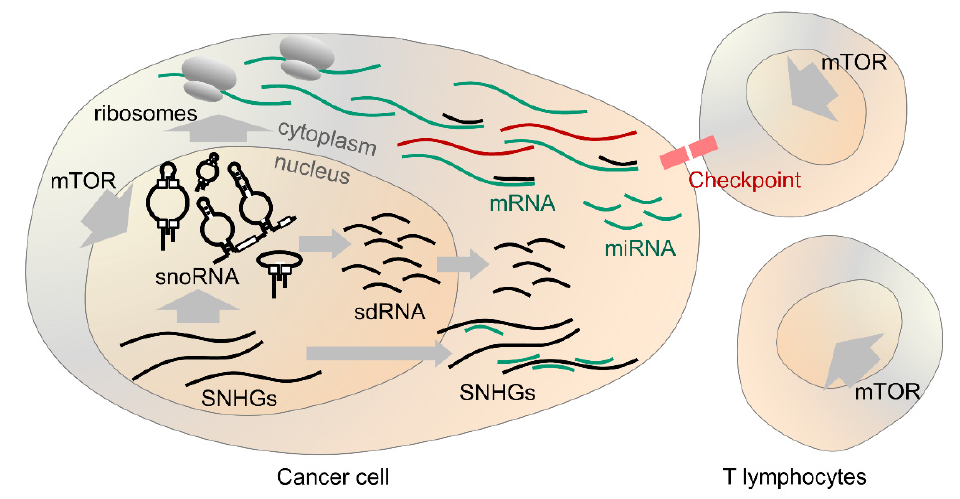
Figure 2. Overview of snoRNA in cancer. SnoRNA expression is promoted by mTOR both in cancer cells and T lymphocytes acting against them. SnoRNA facilitate the production of ribosomes and protein translation. SNHGs produce snoRNA and sponge miRNA in the cytoplasm. SnoRNA derived species may alter splicing and function of mRNAs. In some cases, snoRNA correlate with response to therapeutic targeting of the immune checkpoint proteins.